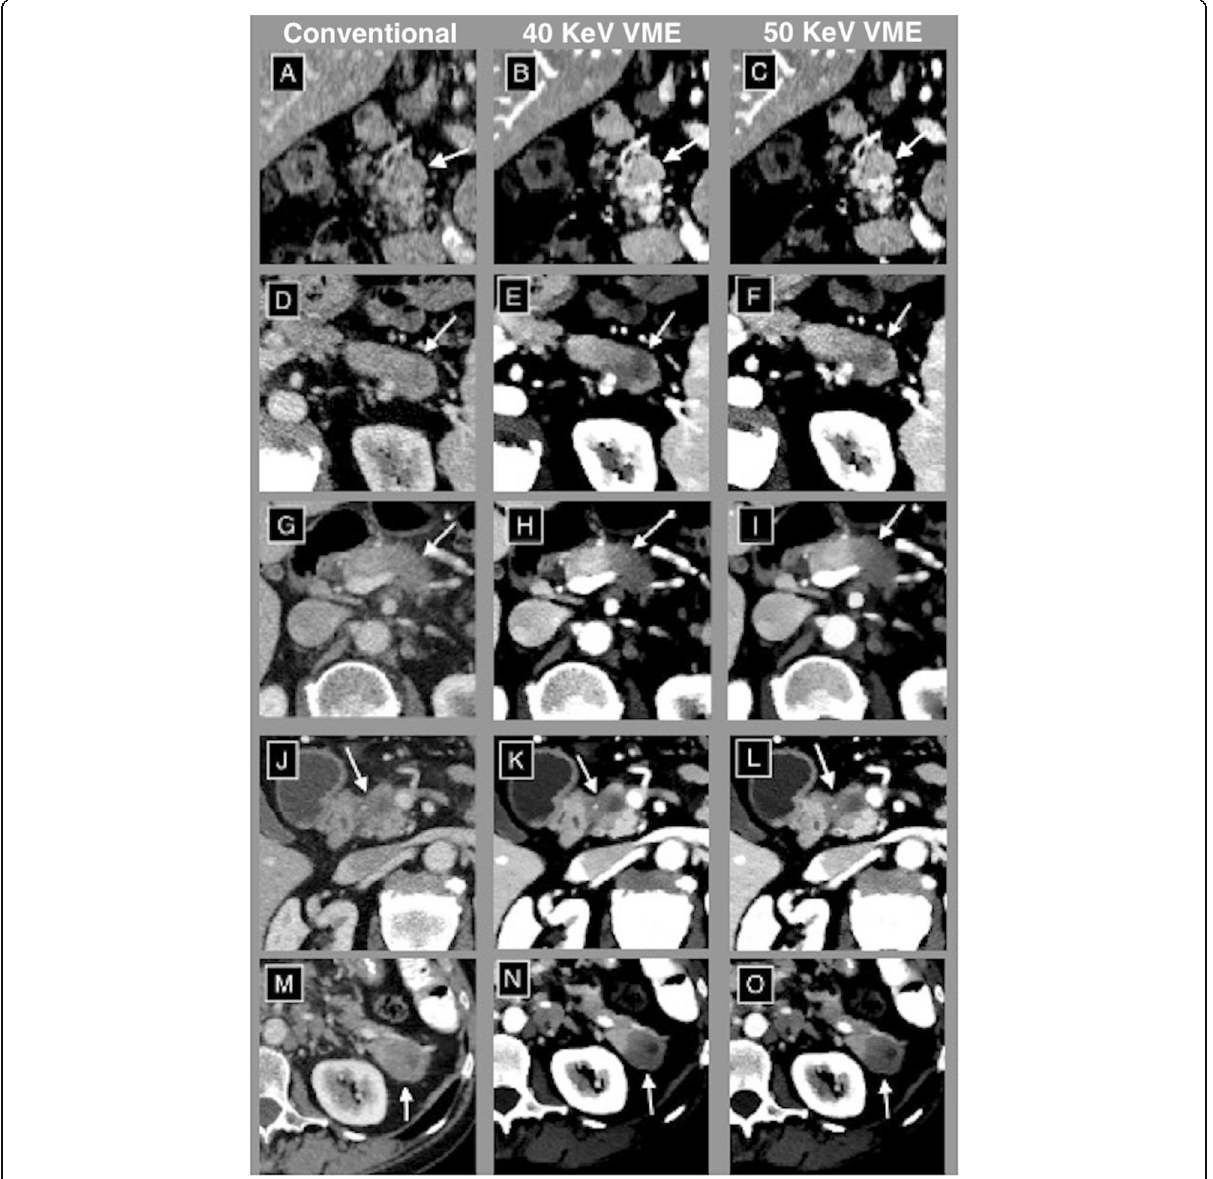
Fig. 3 Examples of conventional images (left column), 40 KeV VME images (middle column) and 50 KeV VME images (right column). Arrows demonstrate boosted visibility of pancreatic lesions in 40 and 50 KeV VME images, showing more distinct boundaries and internal details ( a – c hypovascular neuroendocrine tumor in the pancreatic head; d , e hypovascular neuroendocrine tumor in the pancreatic tail; g – i pancreatic ductal adenocarcinoma in the pancreatic body; j – l uncinate process pancreatic adenocarcinoma showing internal necrosis and fully encased gastroduodenal artery; m , n known metastasis from ovarian cancer with focal